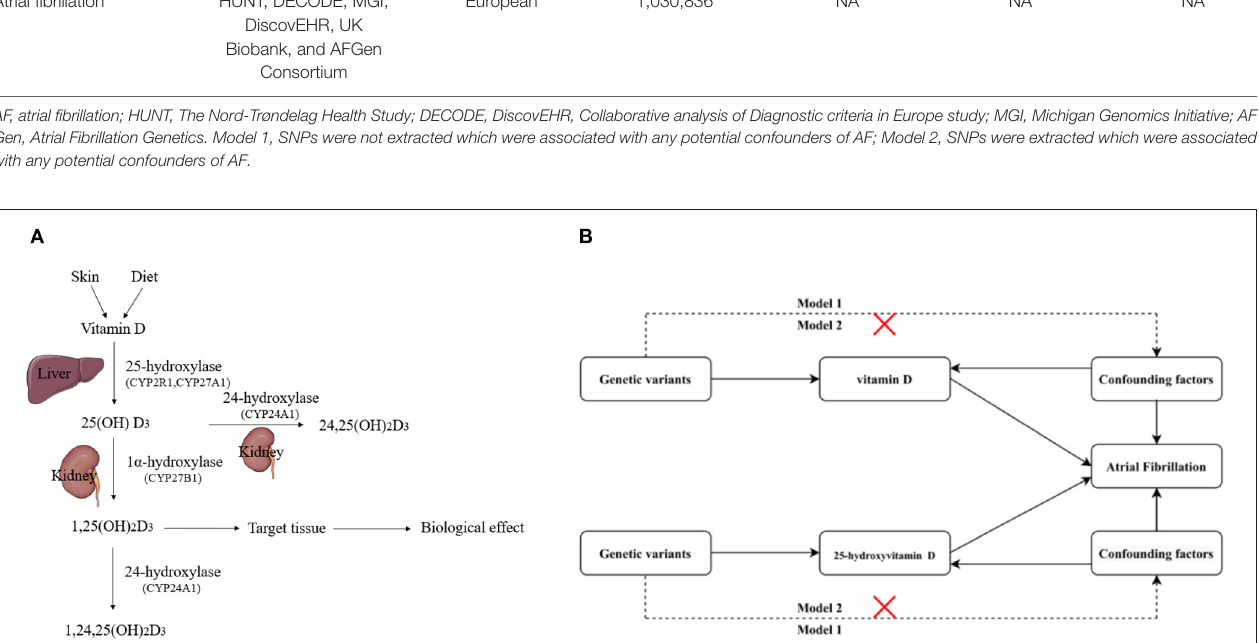
FIGURE 1 | (A) Process of vitamin D metabolism. (B) Schematic overview of the present study design. Model 1, SNPs were not extracted which were associated with any potential confounders of AF; Model 2, SNPs were extracted which were associated with any potential confounders of AF. 25(OH)D 3 , 25-hydroxyvitamin